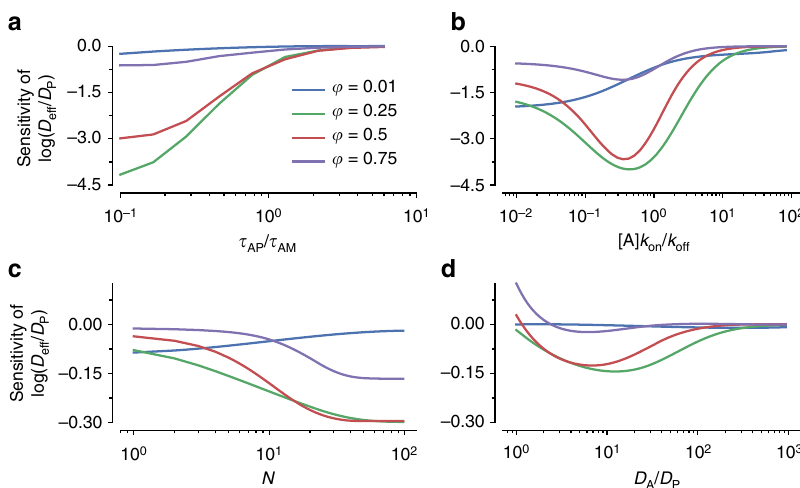
Fig. 6 Sensitivity analysis for parameters that in fl uence the trapping of anchors. Parameters analyzed were a τ AP / τ AM , b A ½ (cid:3) k on = k off , c N , and d D A / D P . (cid:4) (cid:5) Sensitivity is de fi ned as ∂ ∂ p log D eff D , where p can be τ AP = τ AM , A ½ (cid:3) k on = k off , N , or D A / D P . Fixed parameters were D A / D P = 20, N = 20, τ AP = τ AM ¼ 20, (cid:6) Δ D eff D P eff Δ p ′